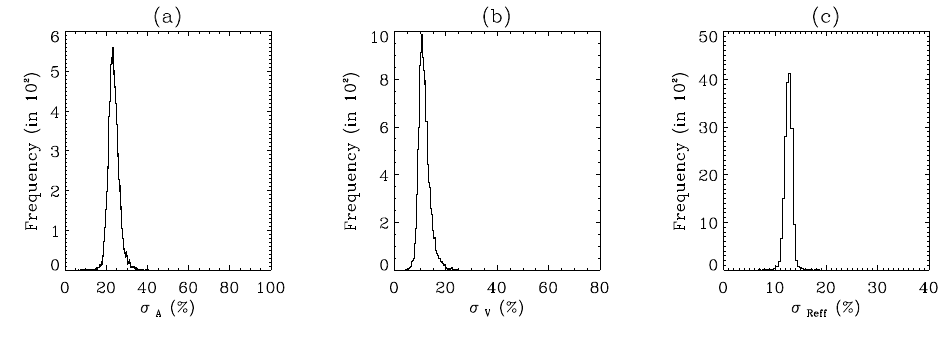
Fig. 10. SAGE II, 12/1999: Histograms of the retrieved uncertainties (in %) in number density N , median particle radius R , and distribution width S .